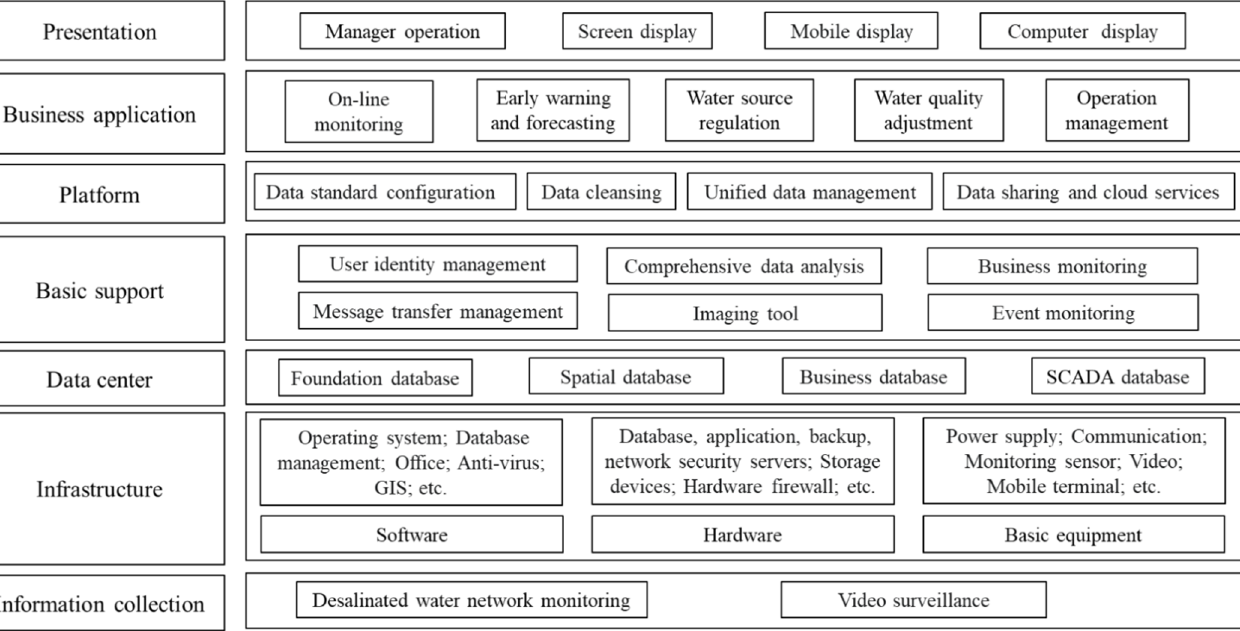
Figure 1. Framework of the safety supervision system for desalinated seawater entering urban water supply network.